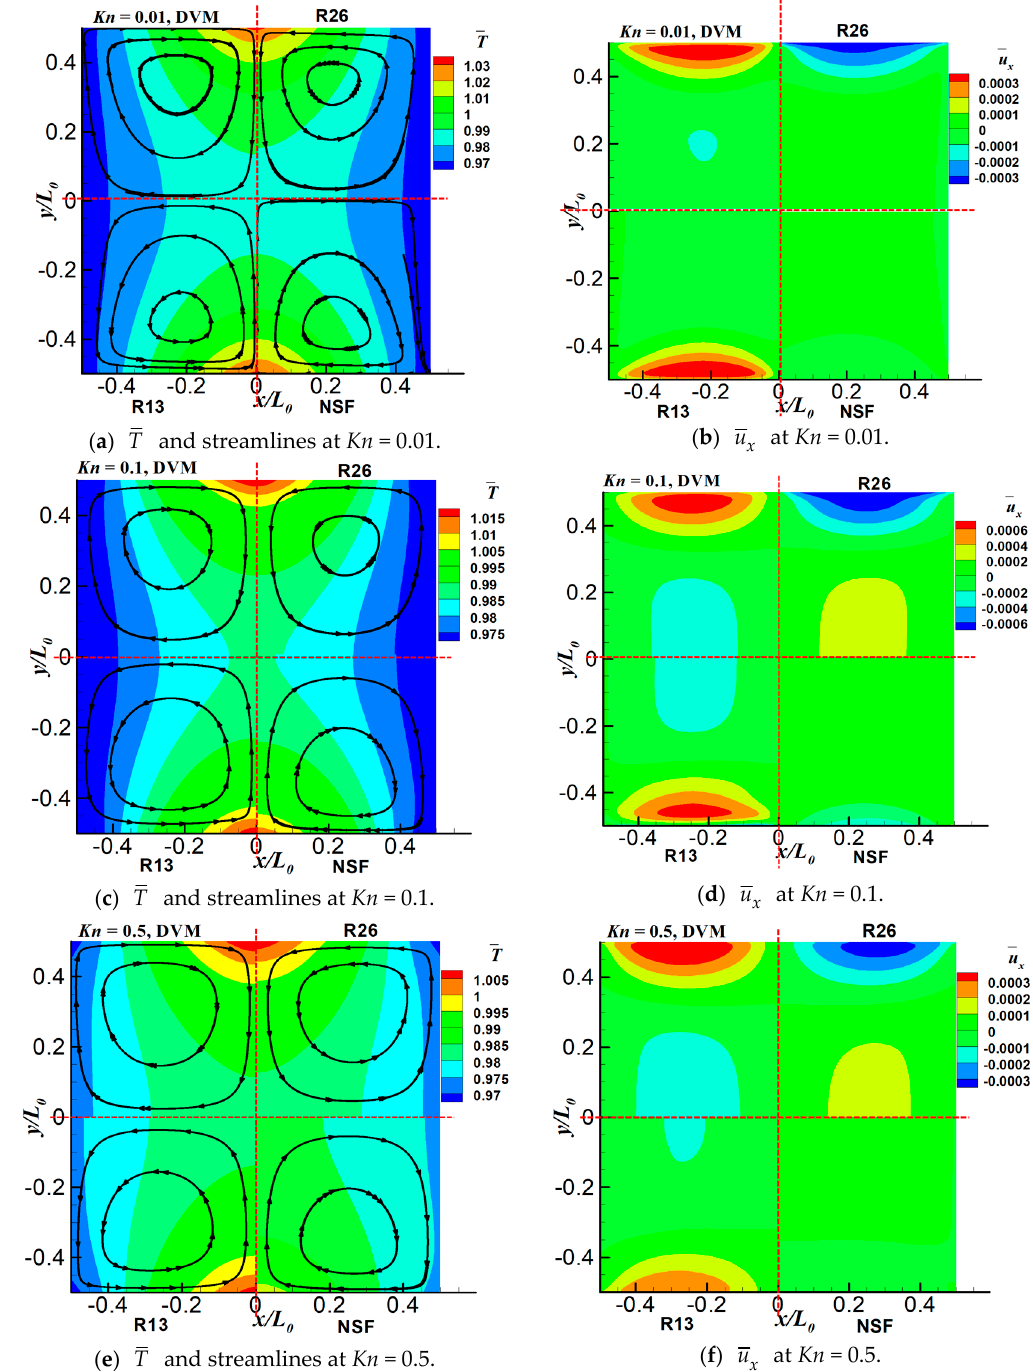
Figure 12. Comparison of T = T / T 0 , u x = u x / 2 RT 0 contours and streamlines of the temperature gradients induced flow case at different Knudsen numbers: ( a , b ) Kn = 0.01, ( c , d ) Kn = 0.1, ( e , f ) Kn = 0.5. Due to symmetry of the problem, in each sub-figure, upper left and upper right are results obtained from the DVM and R26 moment method, respectively; lower left and lower right are results obtained from the R13 moment method and NSF, respectively.